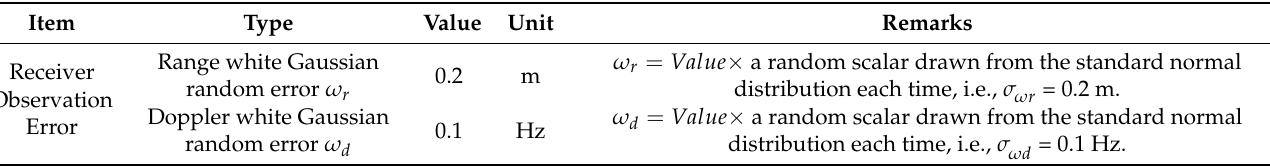
Table 9. Overview of the receiver observation error used in the simulation.